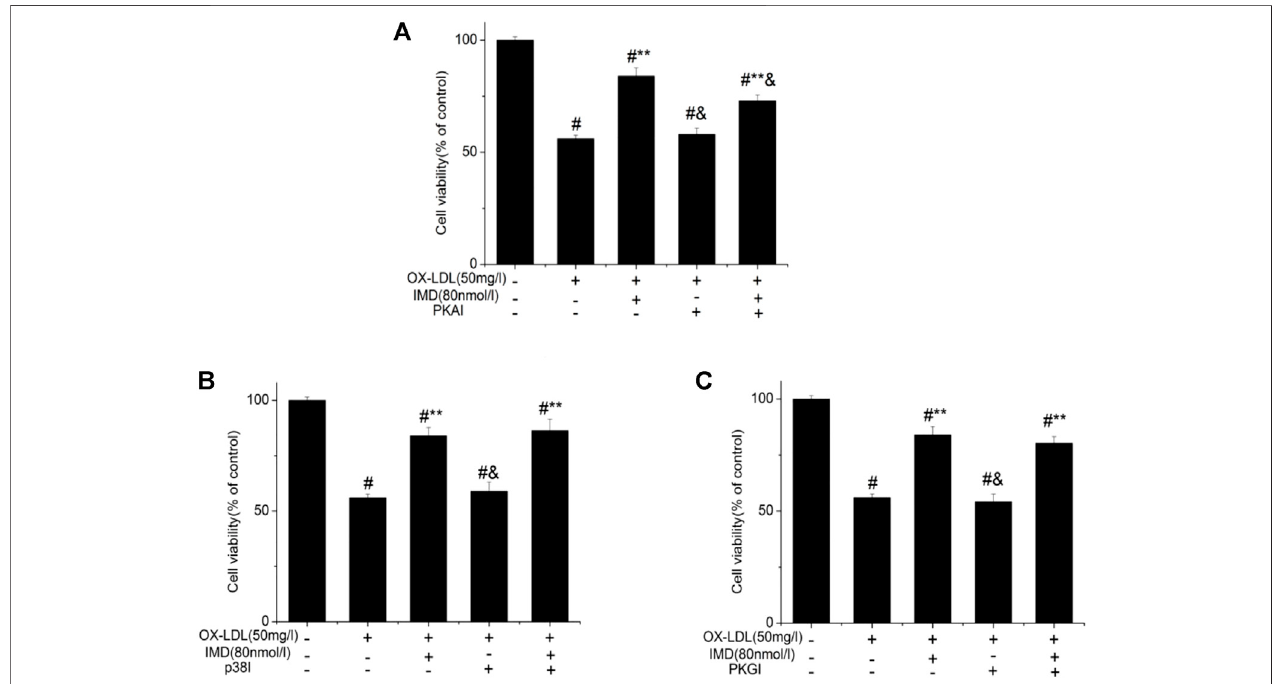
FIGURE 2 | Protective effect ofIMD partially through the PKA pathway. # Compared with the control group ( p < 0.05); ** compared to the ox-LDL alone group ( p < 0.05); & compared to the ox-LDL + IMD group ( p < 0.05).